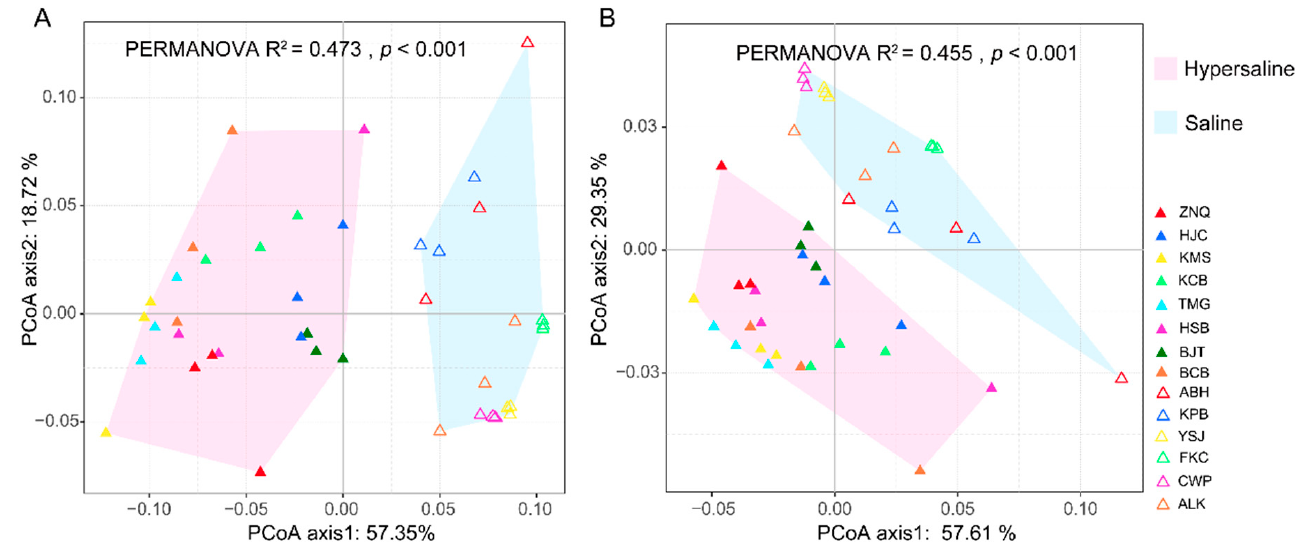
Figure 6. PCoA plot indicating that the saline and hypersaline microbial communities were separated at KEGG orthologues (KO) ( A ) and KEGG pathway level 3 ( B ).